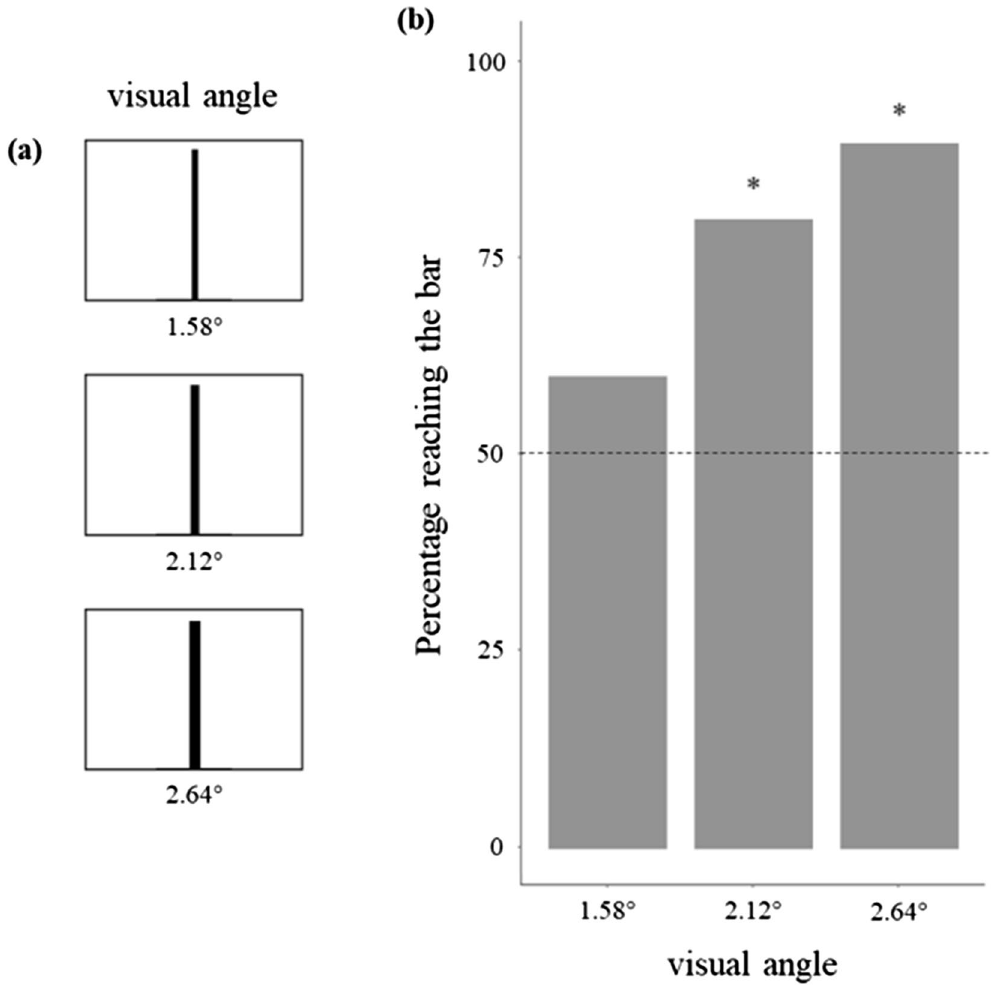
Figure 8. ( a ) Stimuli used in Experiment 5b. ( b ) Percentage of snails reaching the bar in Experiment 6b. Snails showed a preference for the bar with 2.12° visual angle ( P = 0.007) and 2.64° ( P < 0.001), not for bar with 1.58° visual angle ( P = 0.371). Dotted line represents the expected preference by chance, and asterisks indicate significant deviations from the chance level ( P <